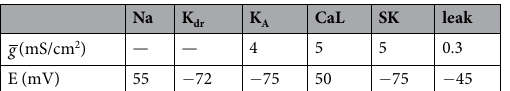
Table 1. Maximal conductances and reversal potentials used in the